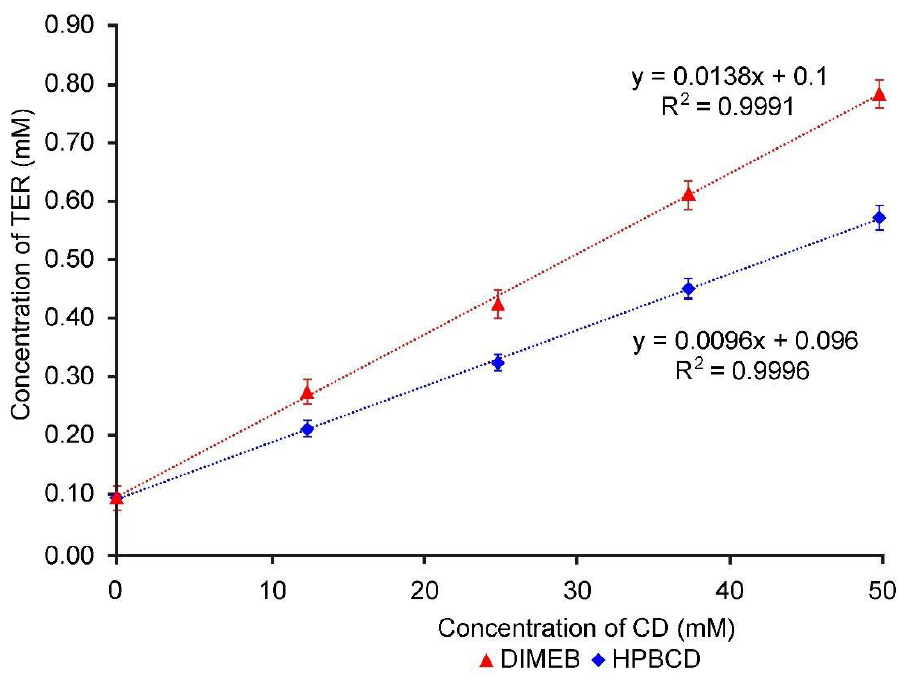
Figure 1. Phase solubility diagrams of TER in aqueous solutions containing DIMEB and HPBCD at 25 ◦